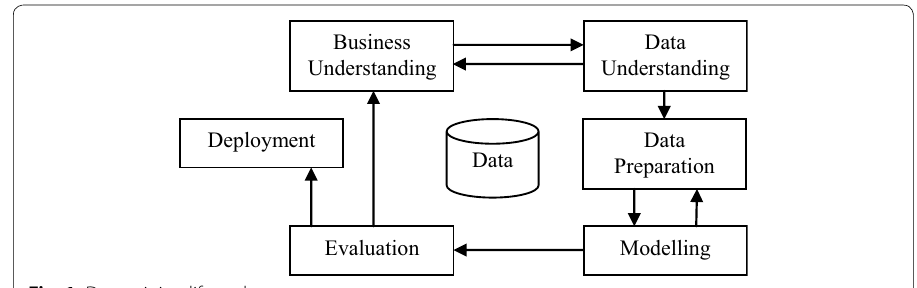
Fig. 1 Data mining life